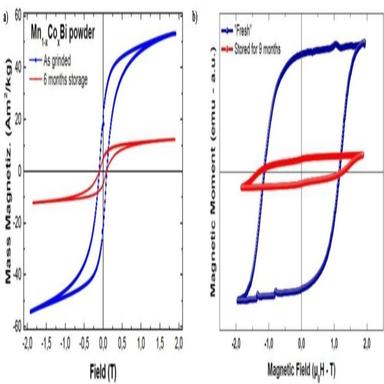
. a) Hysteresis loop for the powder sample as grinded compared to the 6 month storage result. b) Hysteresis loop of orientated "fresh" sample compared to the 9 month storage result.